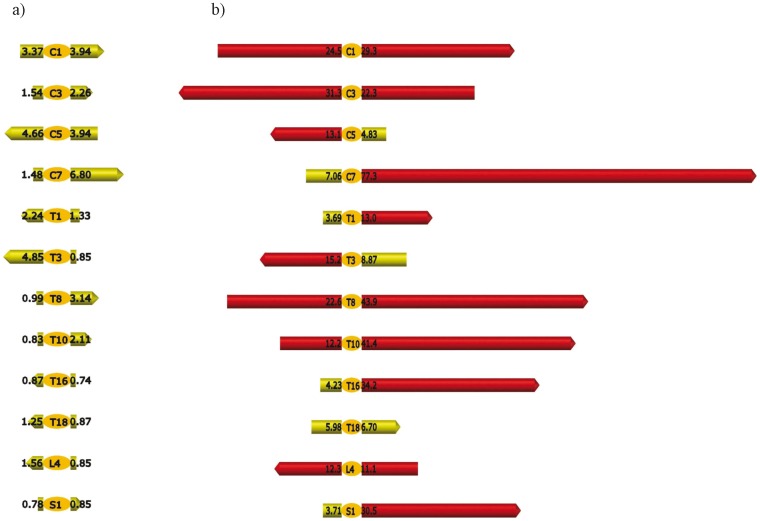
Examples of sEMG signals: representations of values along the spine.a) sEMG signal for a sound horse. The exact values of muscular activity are presented for each tested site in µV (all values <10 µV). Values under 10 µV are represented in green. b) sEMG signal for a severely affected horse with 5 tested sites affected. The exact values of muscular activity are presented for each tested site in µV Values under 10 µV are represented in green and values over 10 µV are represented in red. The five affected sites present a muscular activity over 10 µV on both sides of the spine (C1, C3, T8, T10, L4).